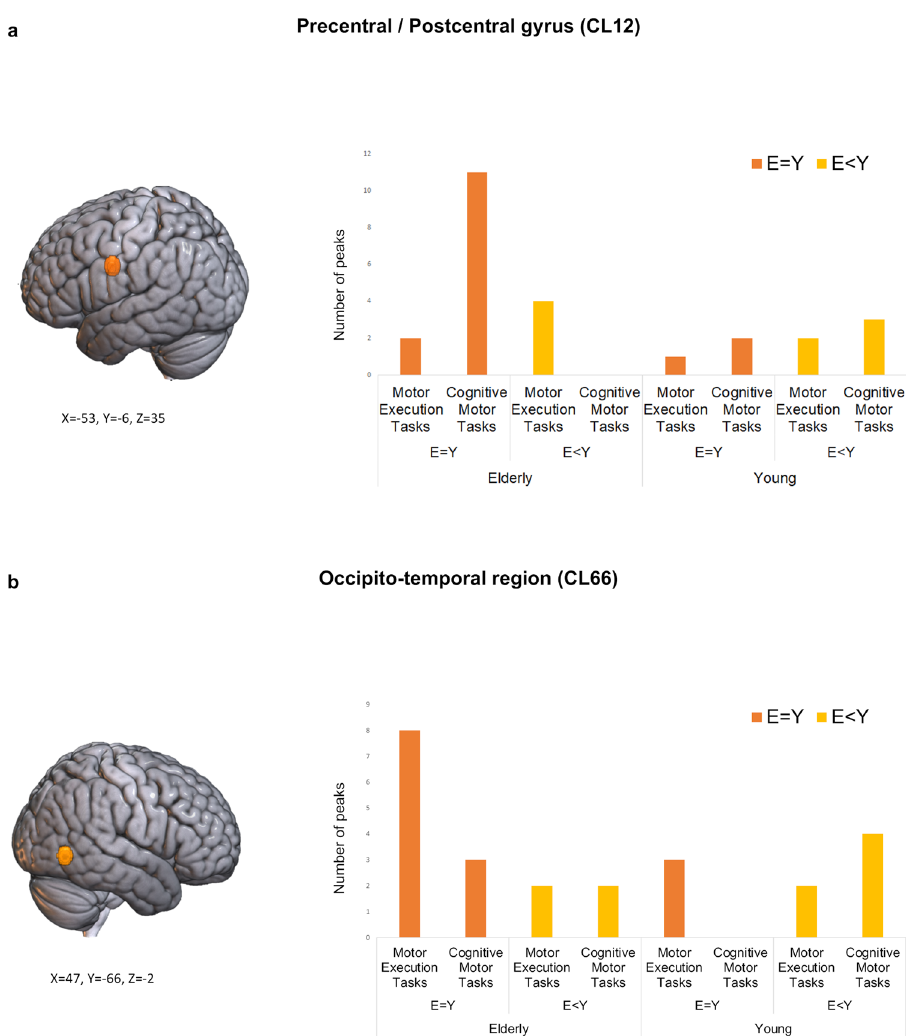
Fig. 4 Clusters showing signi fi cant group-by-performance and task-by-performance interaction effects. a Orange bars indicate the number of peaks of the Precentral/Postcentral gyrus cluster (CL12) associated with an equal performance between the elderly and the young group, while yellow bars indicate the number of peaks associated with a declined performance of the elderly group. b Orange bars indicate the number of peaks of the Occipito-Temporal cluster (CL66) associated with an equal performance between the elderly and the young group, while yellow bars indicate the number of peaks associated with a declined performance of the elderly group in. Plots source data are provided in Supplementary Data